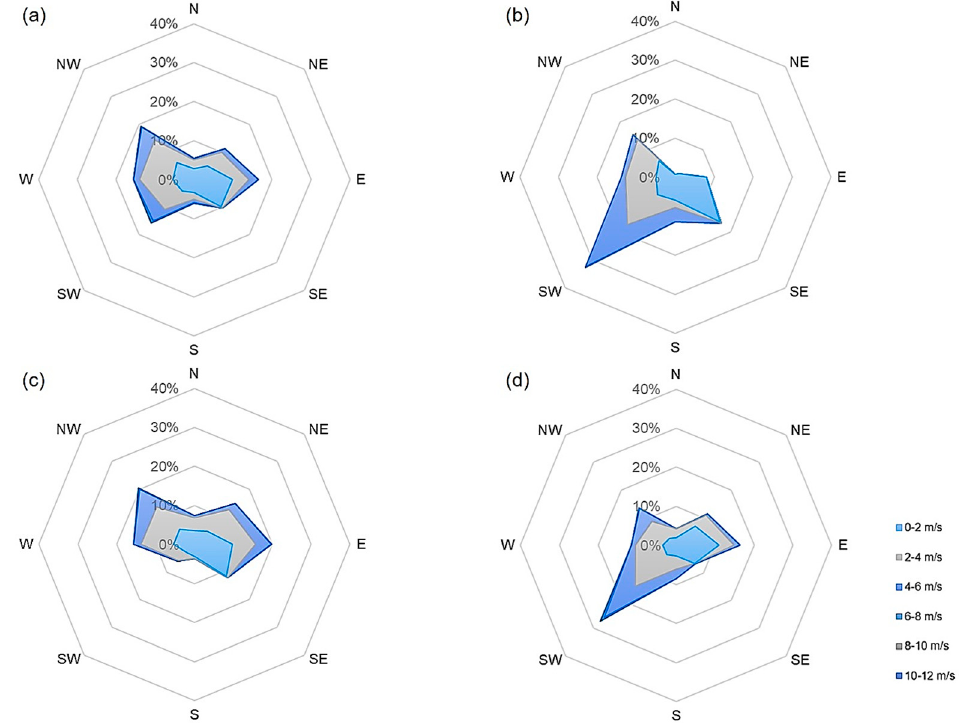
Figure A11. Wind rose from Aero1 during the measurement campaign in 2020 at the location Emmendingen for the periods ( a ) total: 11.03–01.05, ( b ) pre-flowering: 11.03–17.03, ( c ) main flowering: 17.03–17.04, ( d ) post-flowering: 17.04–01.05.